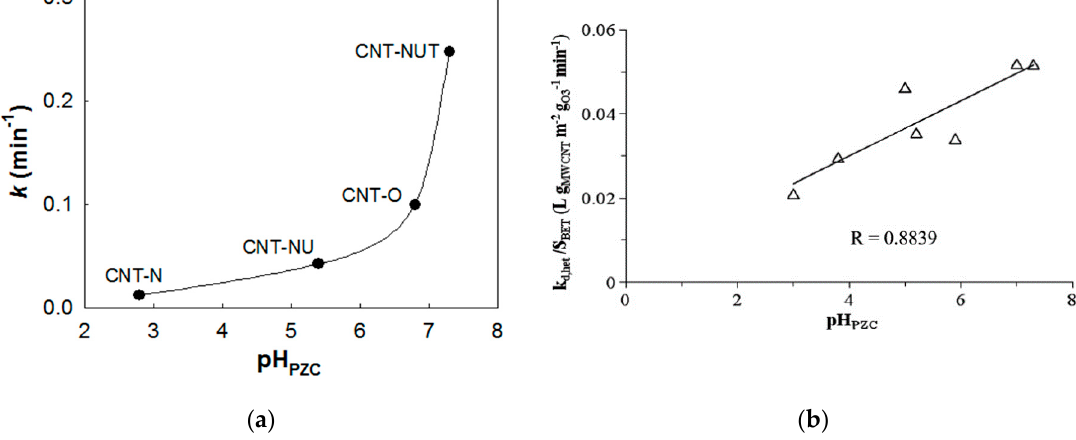
Figure 7. Enhancement of the catalytic activity by increasing the CNTs basicity in ( a ) CWAO: Apparent first-order initial reaction rate constants (k) of oxalic acid degradation vs. pH pzc of CNTs [31] and ( b ) COZ: Normalized rate constants for heterogeneous ozone decomposition vs. pH pzc of CNTs [26]. Reprinted from references [31] and [26] with permission from Elsevier.